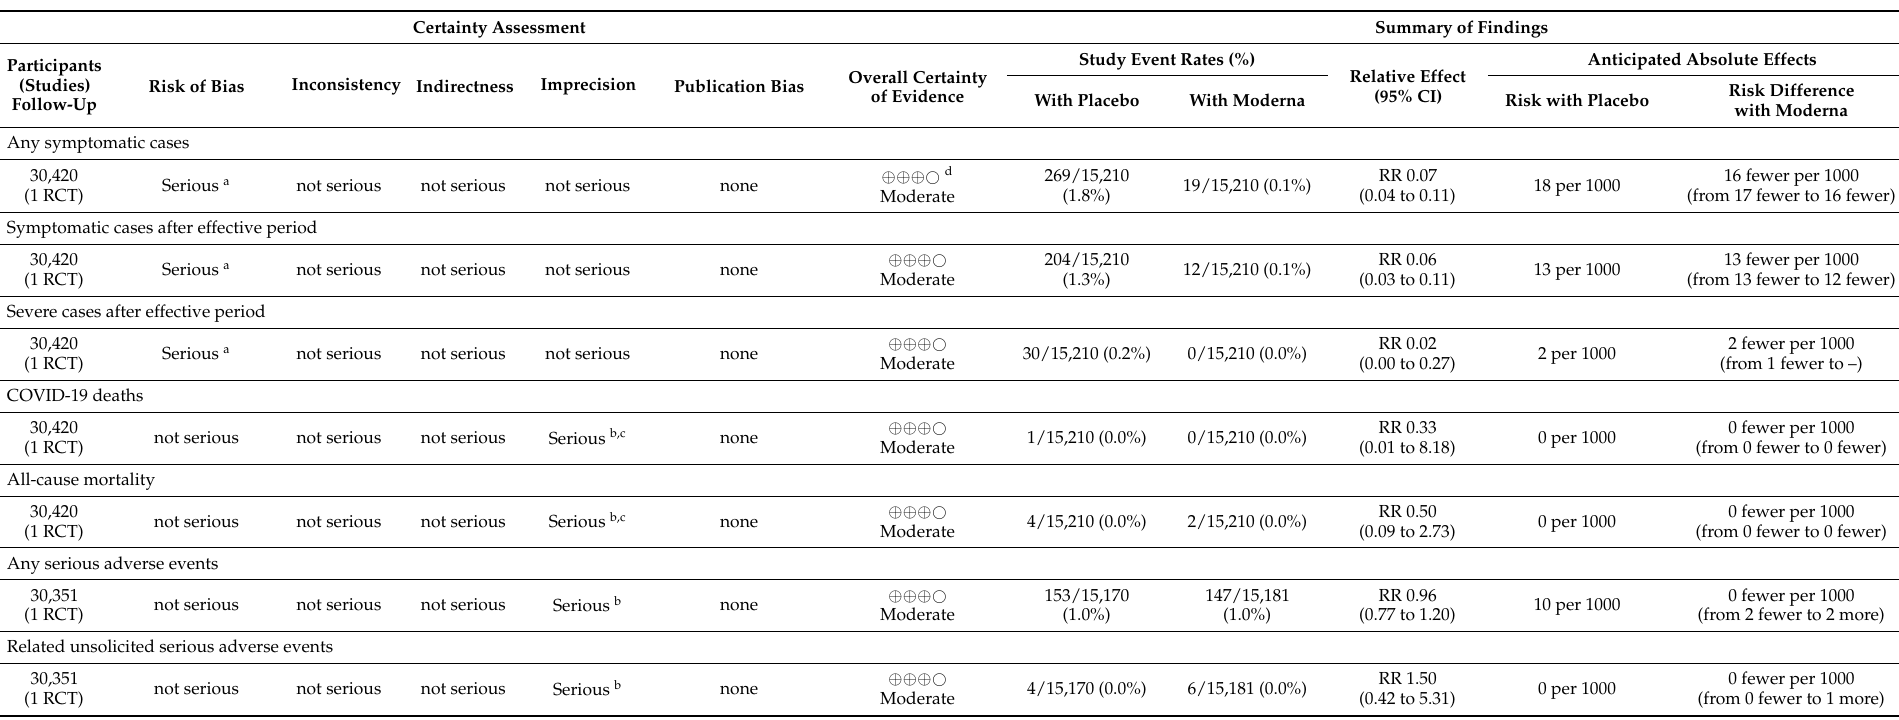
Table 1. GRADE evidence profile denoting the benefits and risks associated with the Moderna vaccine for the prevention of COVID-19 in adults. The table includes relative and absolute effects along with the overall certainty of the